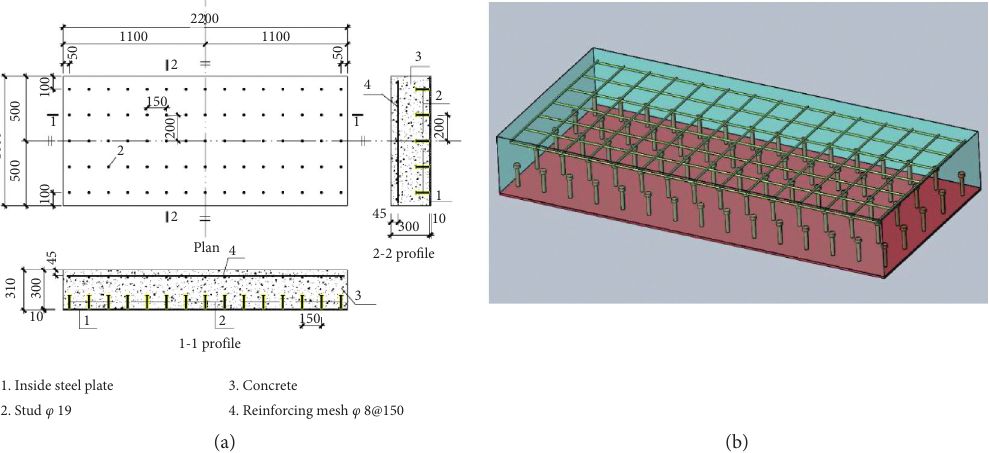
Figure 5: Size and structure of the jointless specimens (unit: mm).